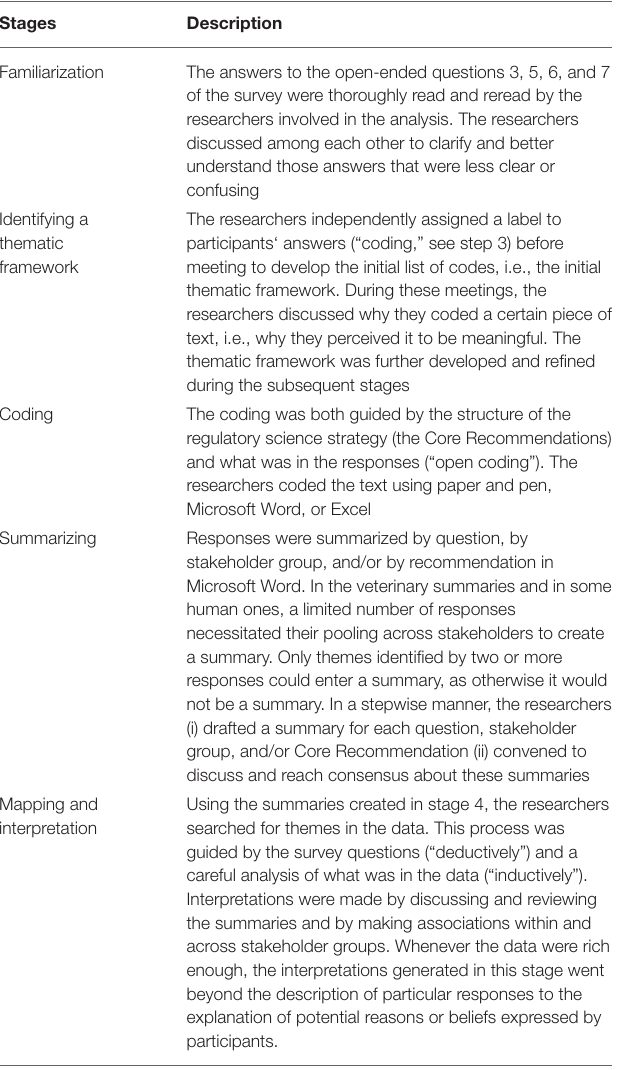
TABLE 1 | Iterative stages of the framework